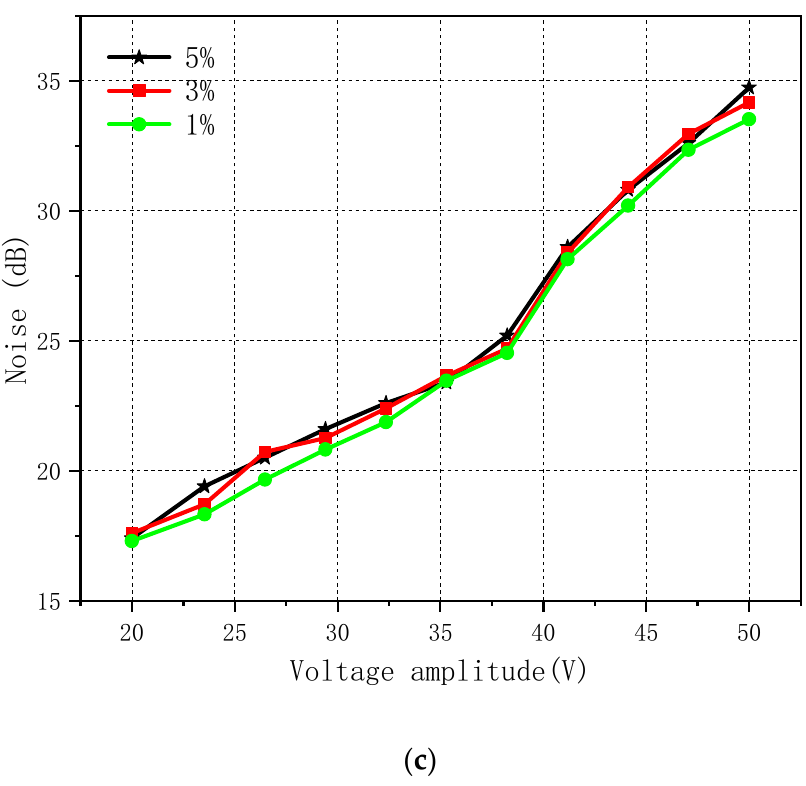
Figure 11. Noise level under excitation with different inter-harmonic content; ( a ) With 5 Hz inter- harmonics; ( b ) With 20 Hz inter-harmonics; ( c ) With 40 Hz inter-harmonics.